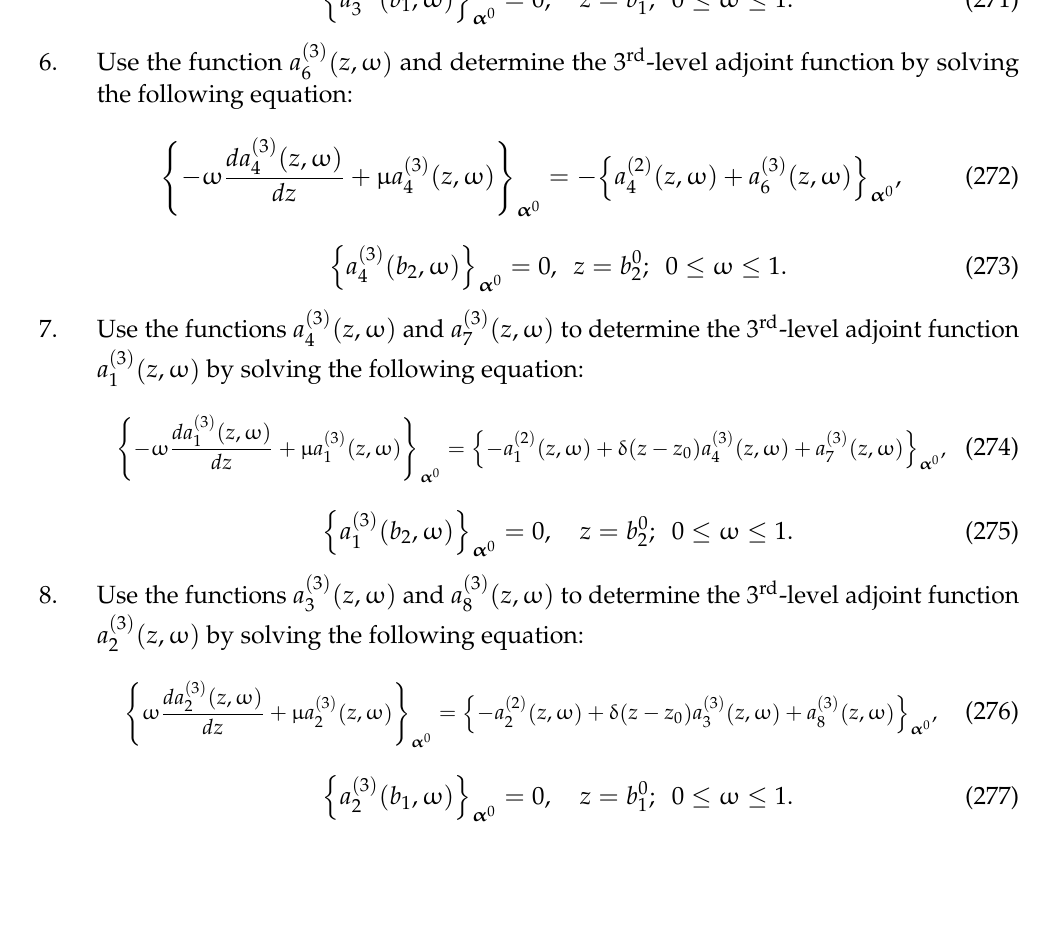
6. Use the function a